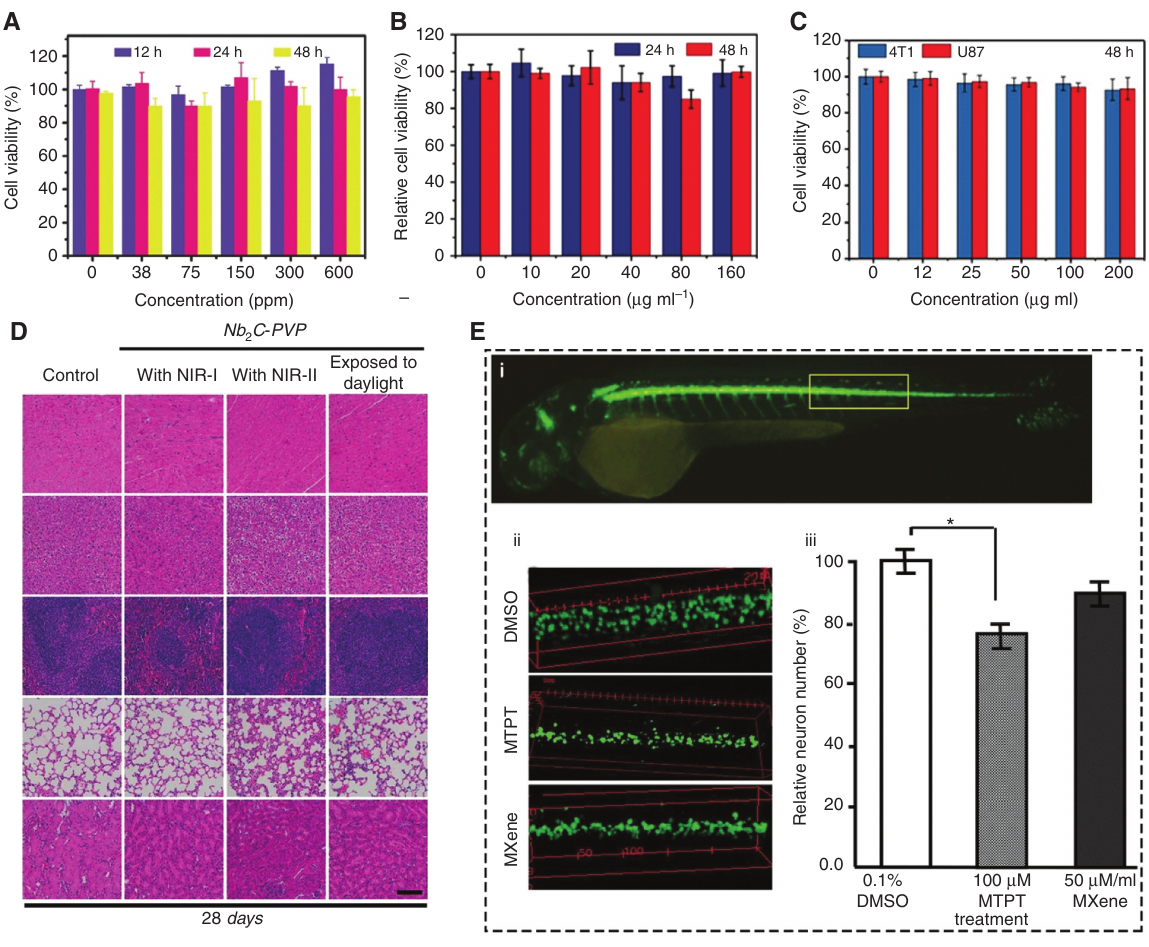
Figure 8: Biocompatibility study of the various concentrations of MXenes on the 4T1 cell line or U87 cells. (A) Ti C -SP nanosheets. (B) MnO /Ti C -SP nanosheets. (C) Nb C-PVP nanosheets. (D) Hematoxylin and eosin staining for major organs after 3 2 x 3 2 2 Nb C-PVP nanosheet treatment at 28 days after injection under NIR-I, NIR-II, and daylight (scale bars: 100 μ m). (E) i, fluorescence imaging of 2 an entire embryo; ii, confocal pictures of the spinal cord adjacent to the somite 14–17 territory after treatments with DMSO,